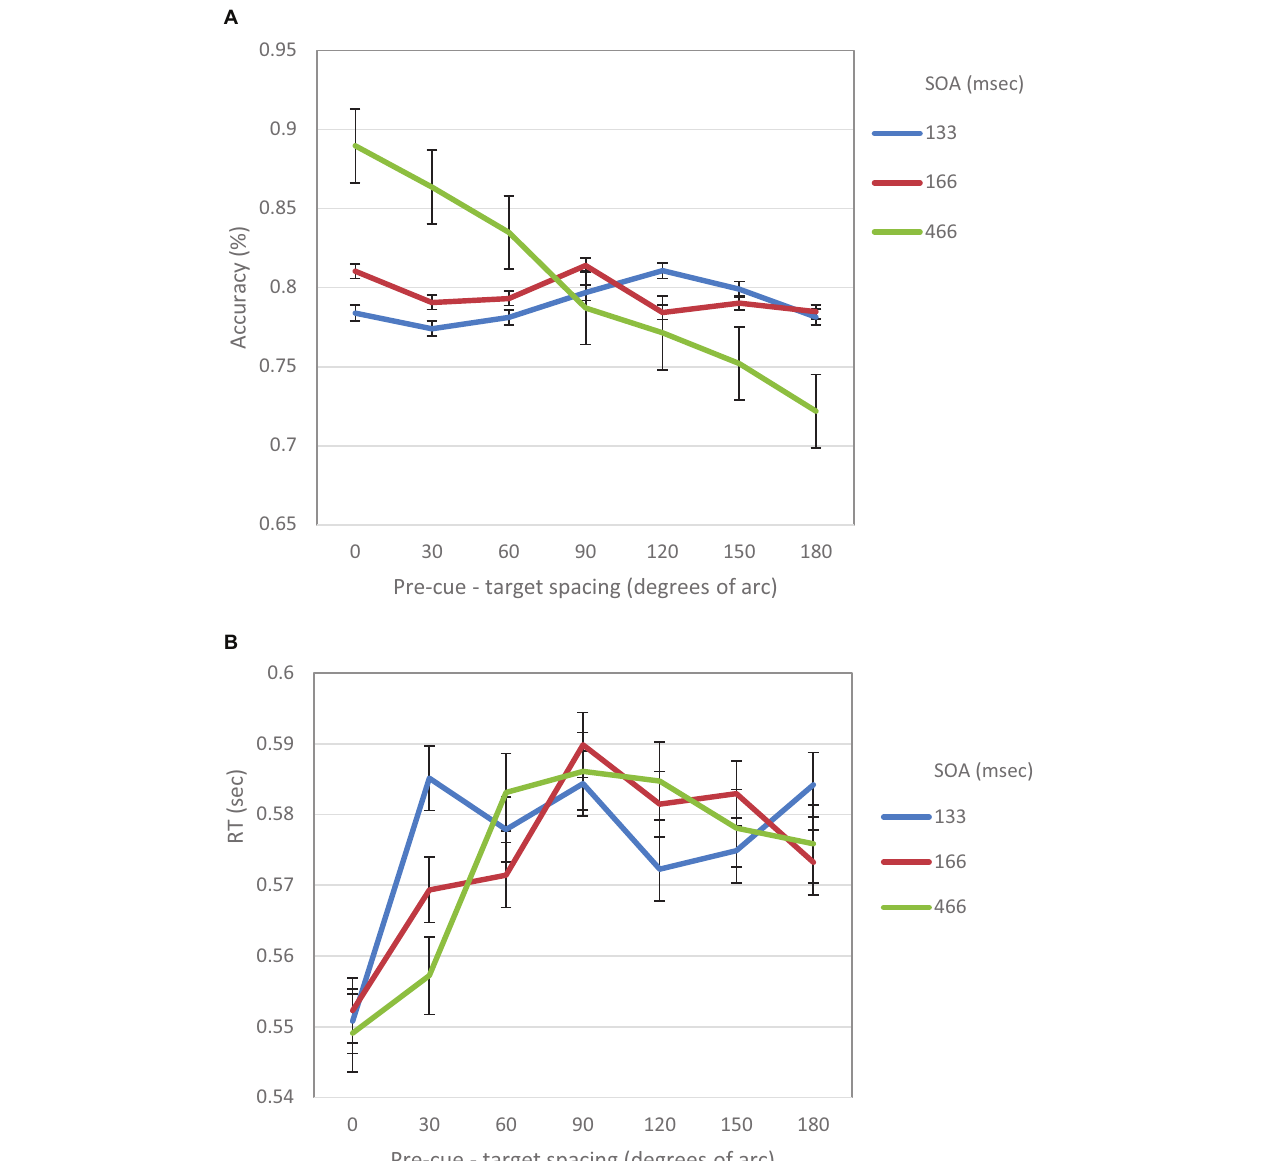
FIGURE 5 | (A) Accuracy in Experiment 1 as a function of pre-cue – target spacing and SOA. (B) RT in Experiment 1 as a function of pre-cue – target spacing and